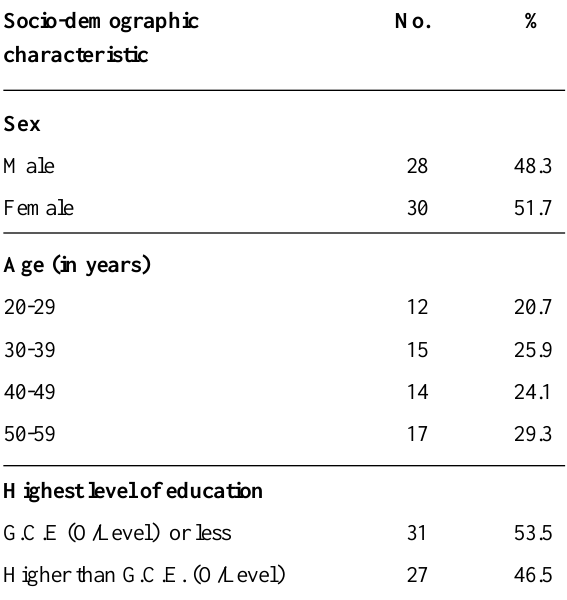
Table 1. Socio-demographic